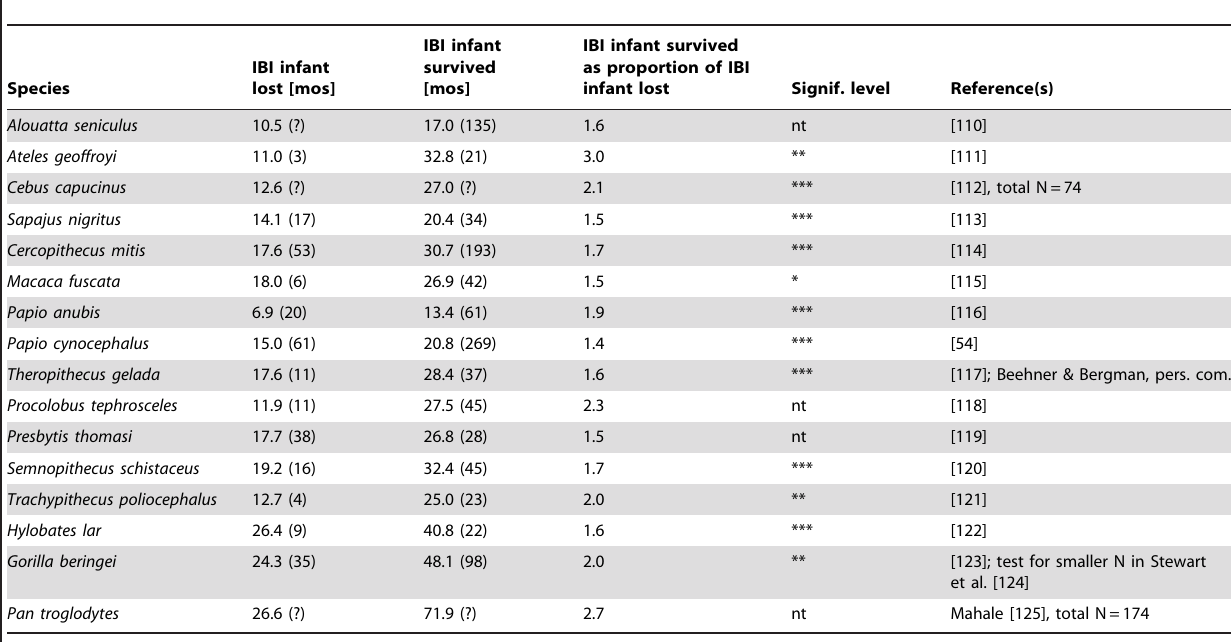
Table 2. The effect of premature infant loss on the subsequent interbirth interval (IBI) for example species from all major primate radiations in taxonomic